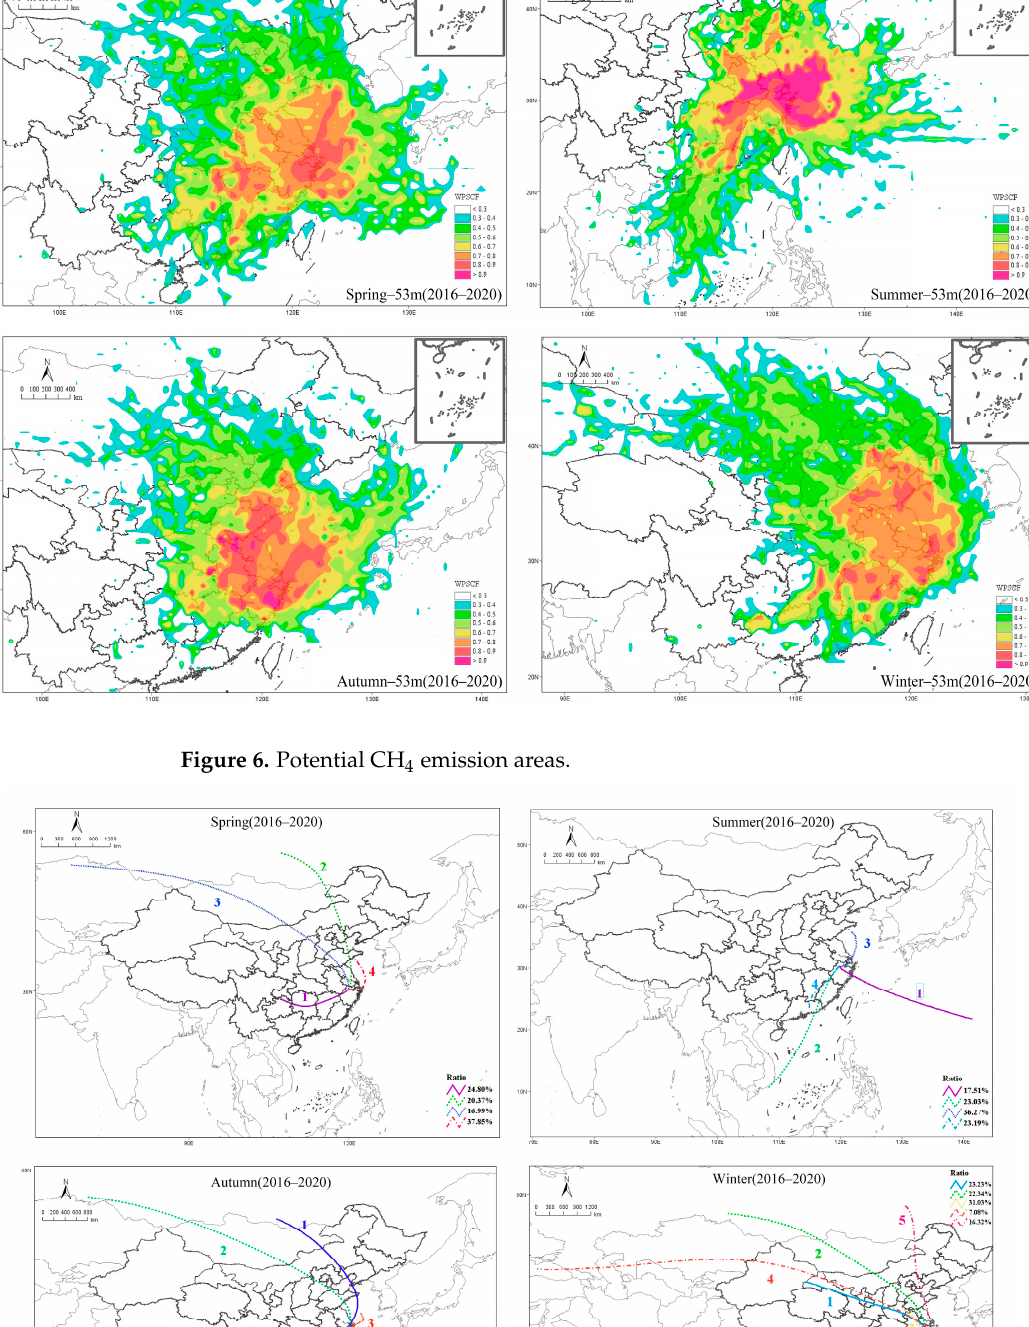
Figure 7. Trajectory clustering